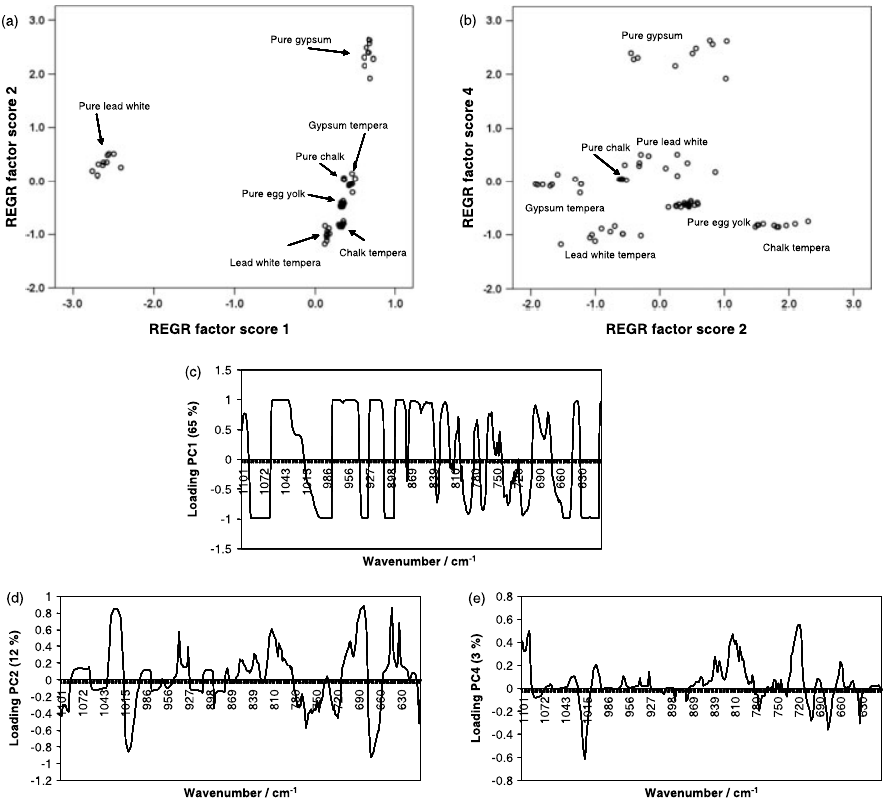
Figure 7. White model samples: ( a ) score plot of PC1 and PC2; ( b ) score plot of PC2 and PC4; ( c ) loading plot of PC1; ( d ) loading plot of PC2; ( e ) and loading plot of PC4. (Reproduced from work in [38] with the permission of Wiley, copyright 2010.)